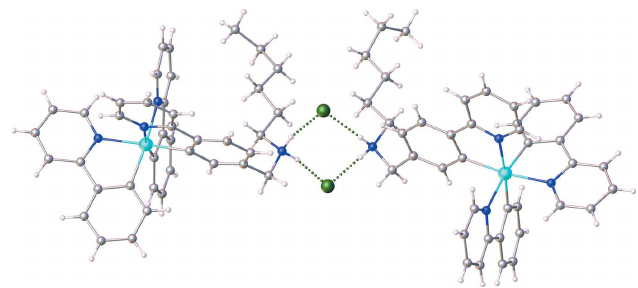
Figure 2 A perspective view of the title compound, showing the intermolecular